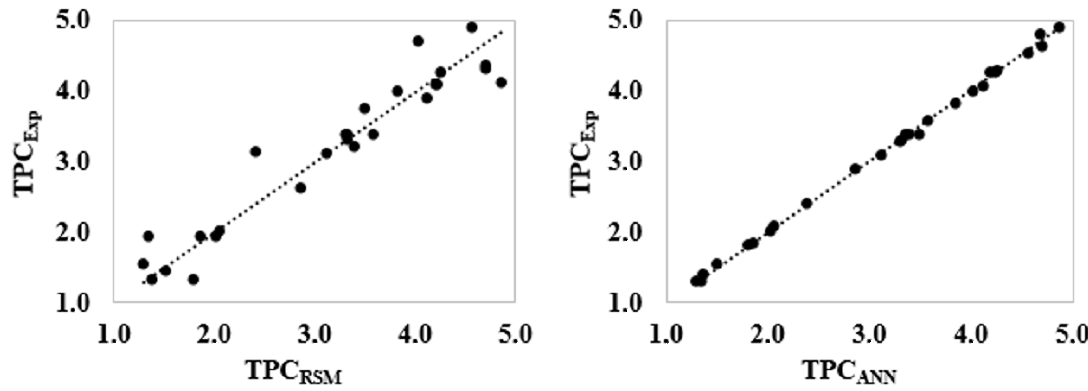
Figure 4. Comparison of the experimental total phenolic content (TCP Exp ) and those predicted by response surface methodology (TPC RSM ) and artificial neural network (TPC ANN ).